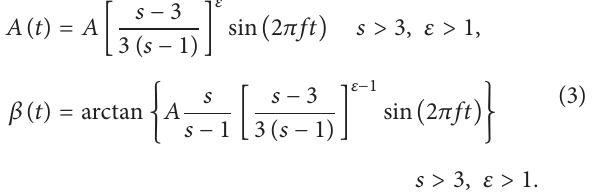
Figure 3: Physical